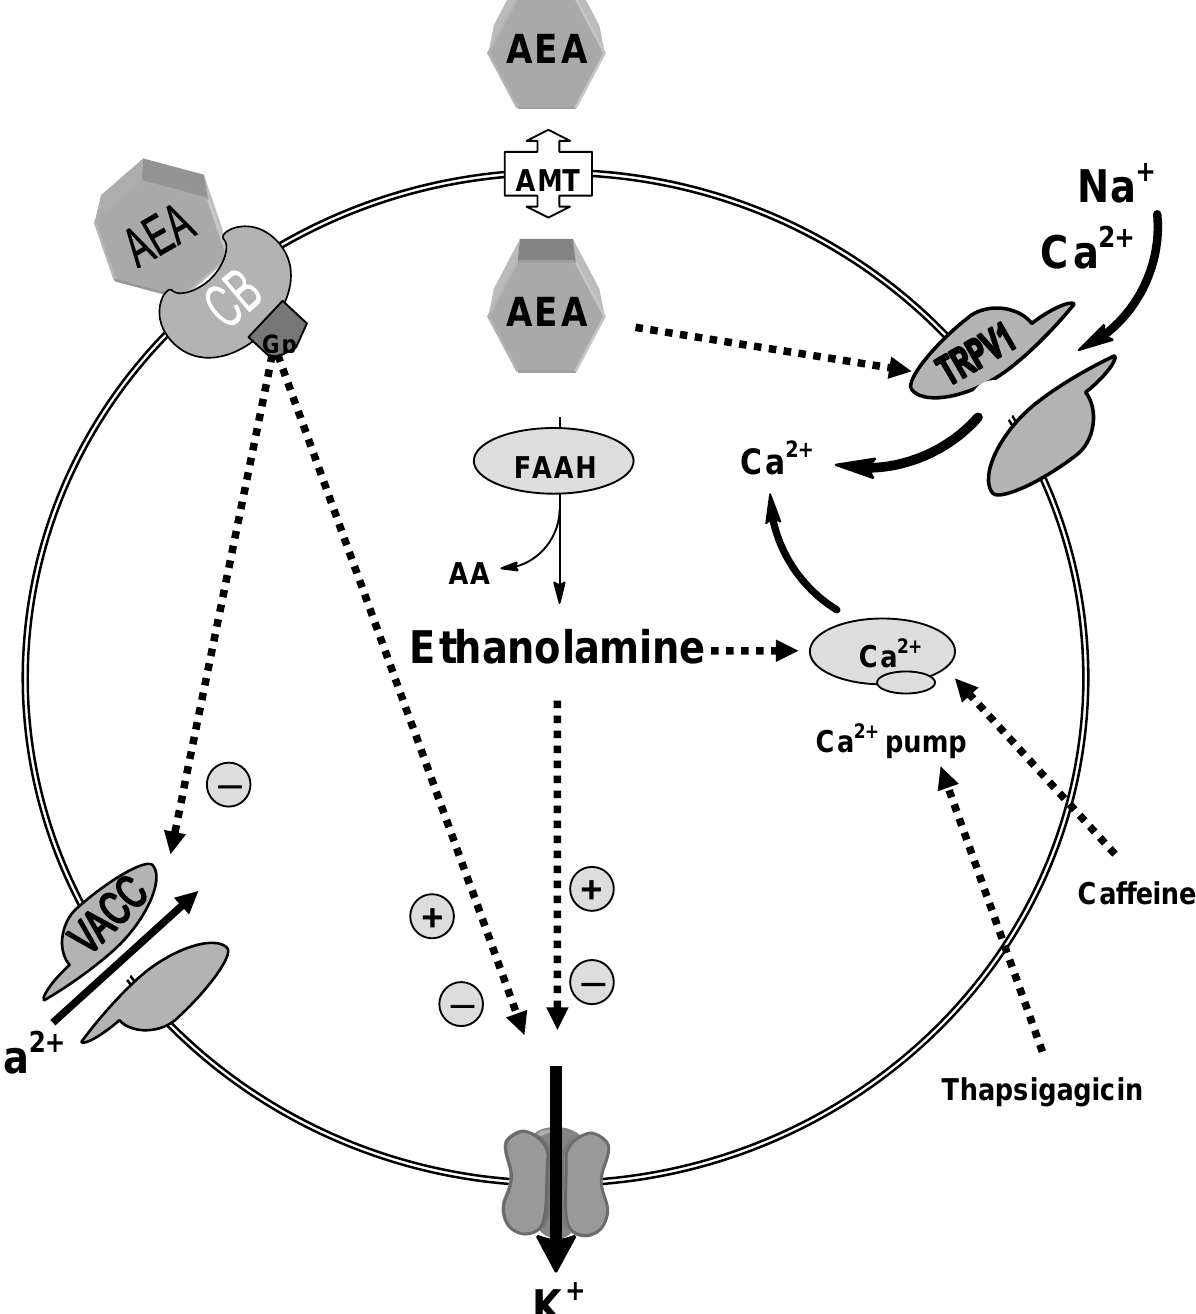
Figure 3. Schematic diagram showing the possible mechanisms of ethanolamine actions; our data suggested that enhancement of the intracellular Ca 2+ level produced by ethanolamine is mediated through intracellular signalling mechanism influencing the thapsigargicin and caffeine-sensitive stores. Ethanolamine modulation of the potassium conductance is mediated independently from increased intracellular